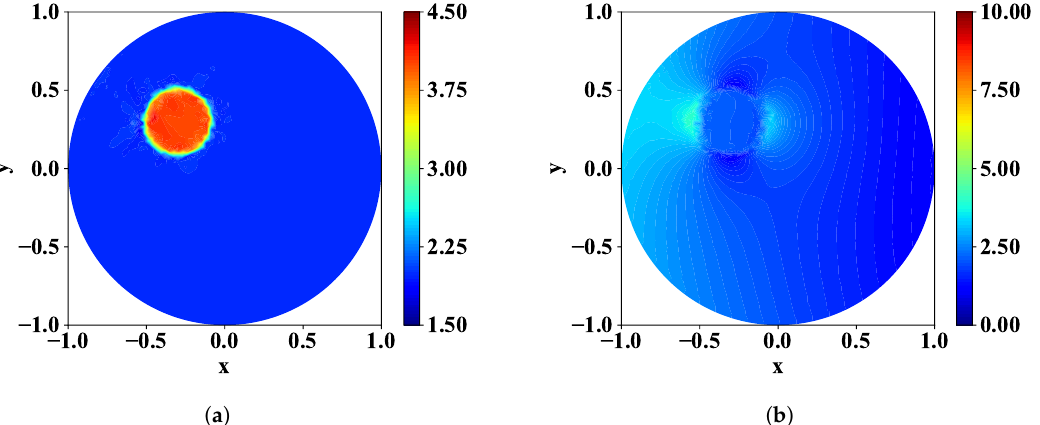
Figure 5. When SNR = ∞ , σ = 4.0S/m and the step is 12: ( a ) the reconstructed image and ( b ) the power density.